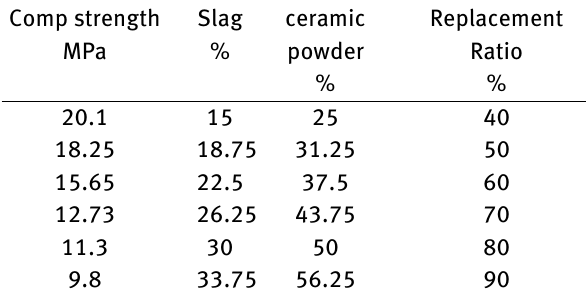
Table 11: Compressive strength of cubes (50 mm) replacement of